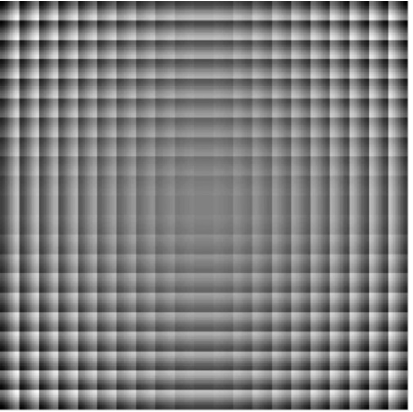
Figure 10. Visualisation of the convex envelope of {𝐹 (cid:2869)(cid:2869) , 𝐹 (cid:2869)(cid:2870) , 𝐹 (cid:2870)(cid:2869) } defined in (4).